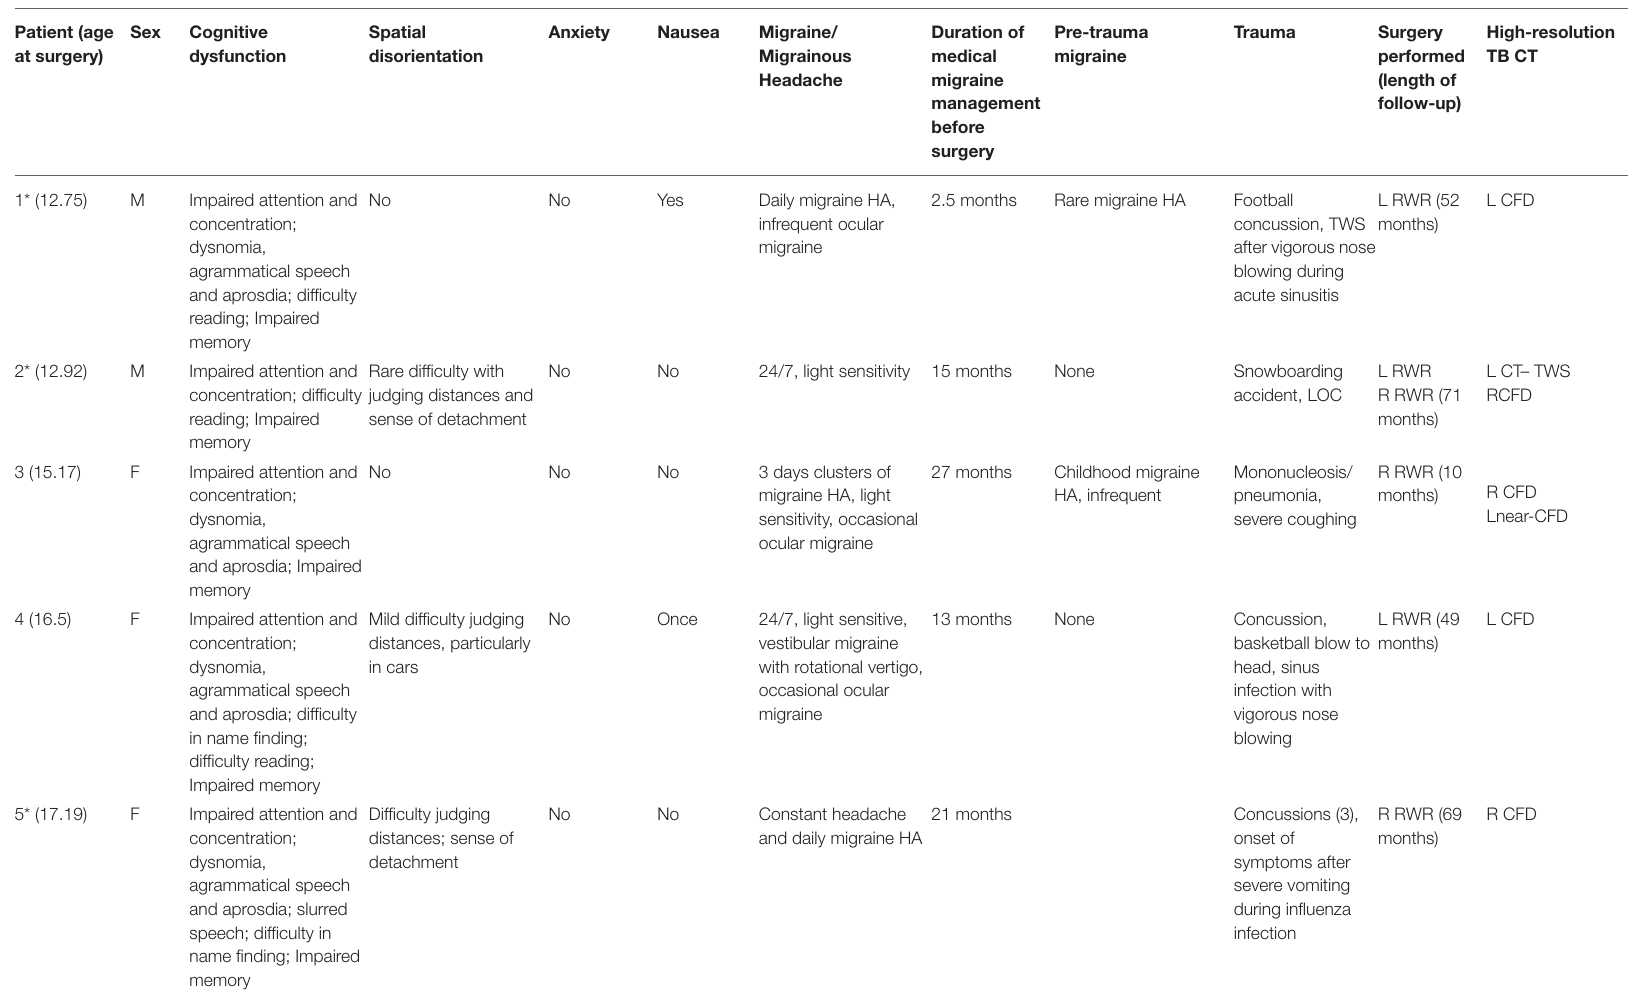
TABLE 2 | Patient demographics, history, symptoms, and results of diagnostic studies in 16 patients with cochlea-facial nerve dehiscence. Group 1: Cochlea-facial nerve dehiscence and third window syndrome patients who underwent round window reinforcement surgery Patient (age at